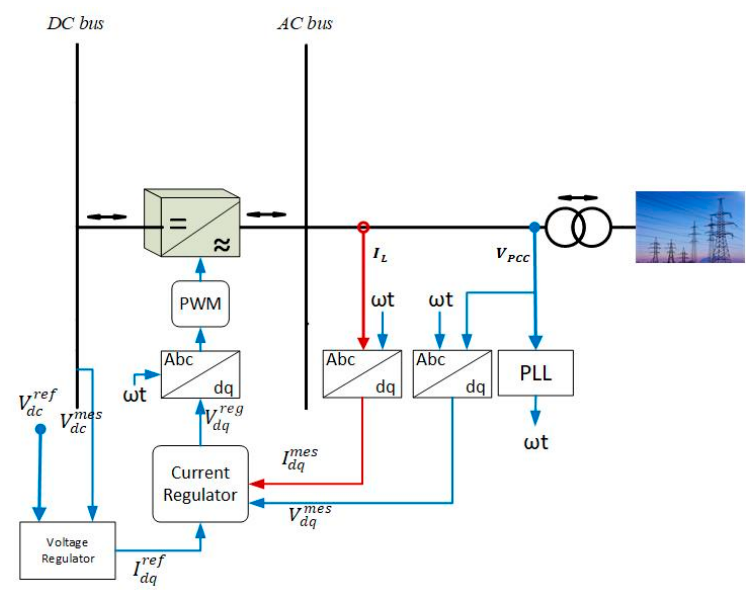
Figure 5. Control design of the grid side converter. PWM: pulse width modulation; PLL: phase locked loop.